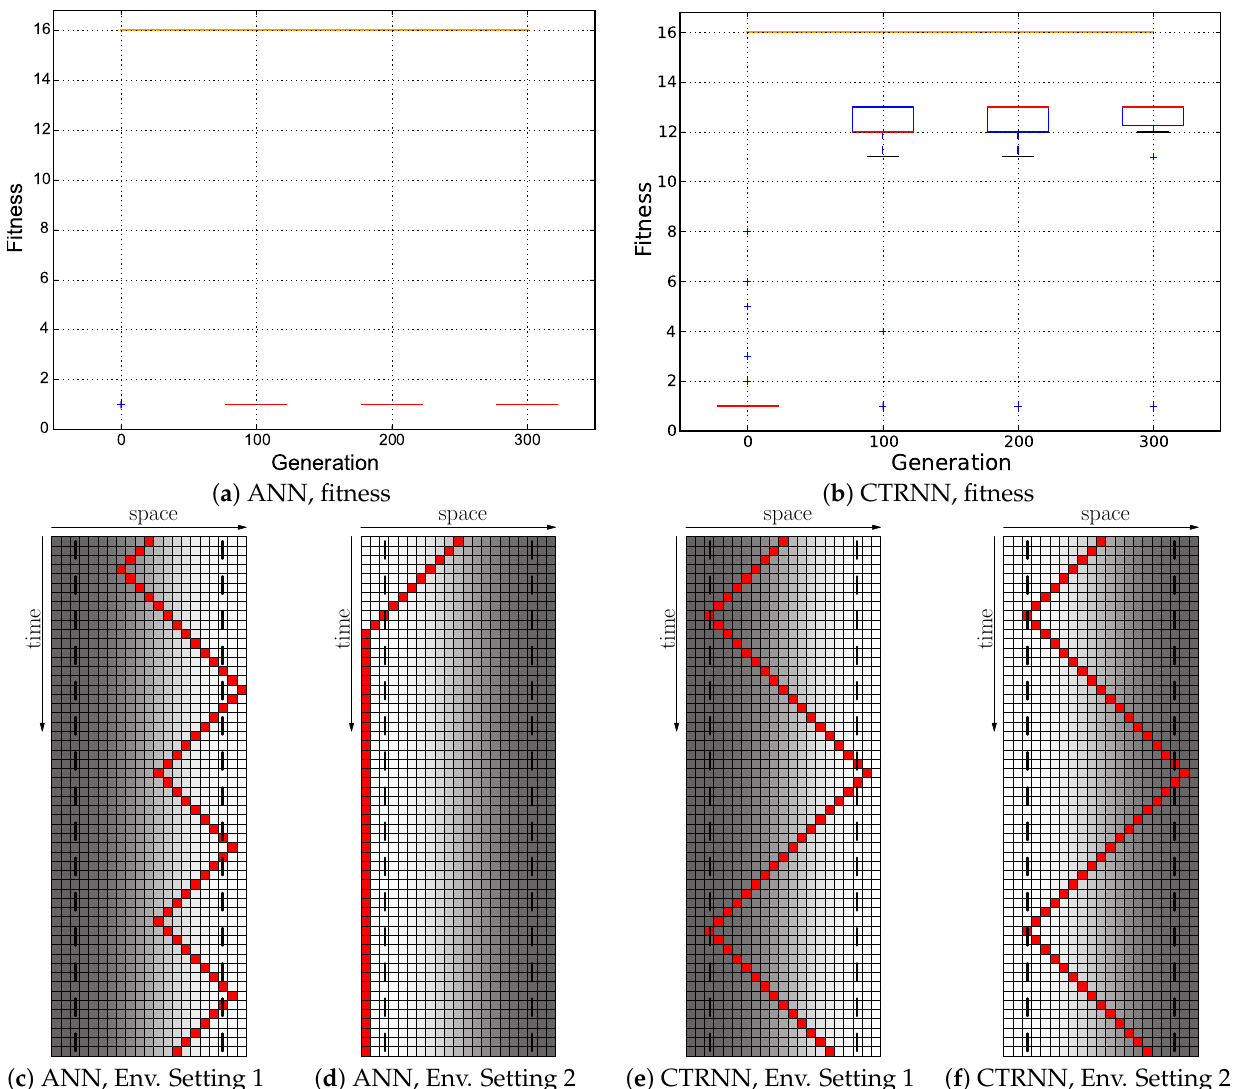
Figure 8. Evolutionary results of the double environment setting, fitness regime Switch : fitness = F ( 1,0,0 ) . The minimum of both evaluations was used as the fitness value for a genome. Top row: fitness dynamics of the ANNs (left) and CTRNNs (right). The horizontal orange line indicates the maximum fitness achievable by a reactive Wankelmut controller, as it was achieved by the simple hand-coded controller. Bottom row: trajectory of the best performing genome of both controller types in both environments used in evolution (only the initial 56 time steps of 250 time steps are